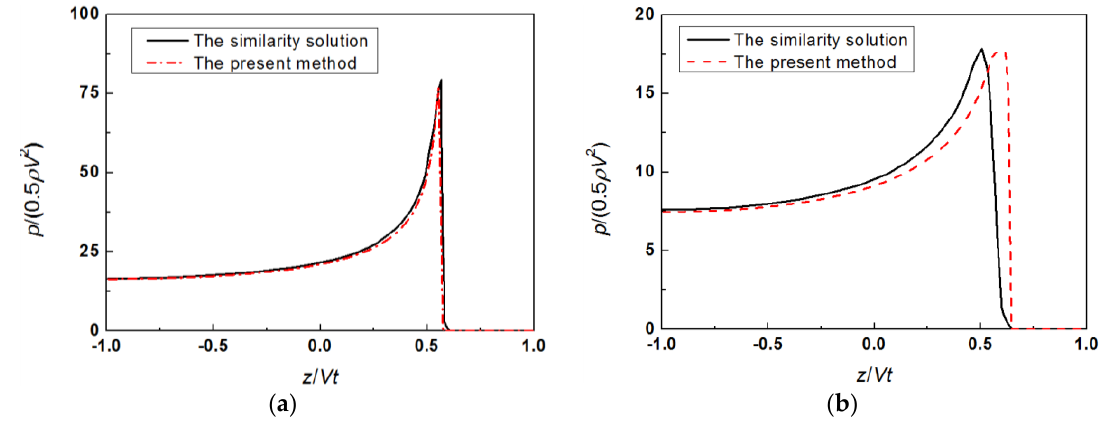
Figure 5. Comparison of the pressure distribution before the flow separation. ( a ) 10° deadrise angle; ( b ) 20° deadrise angle.